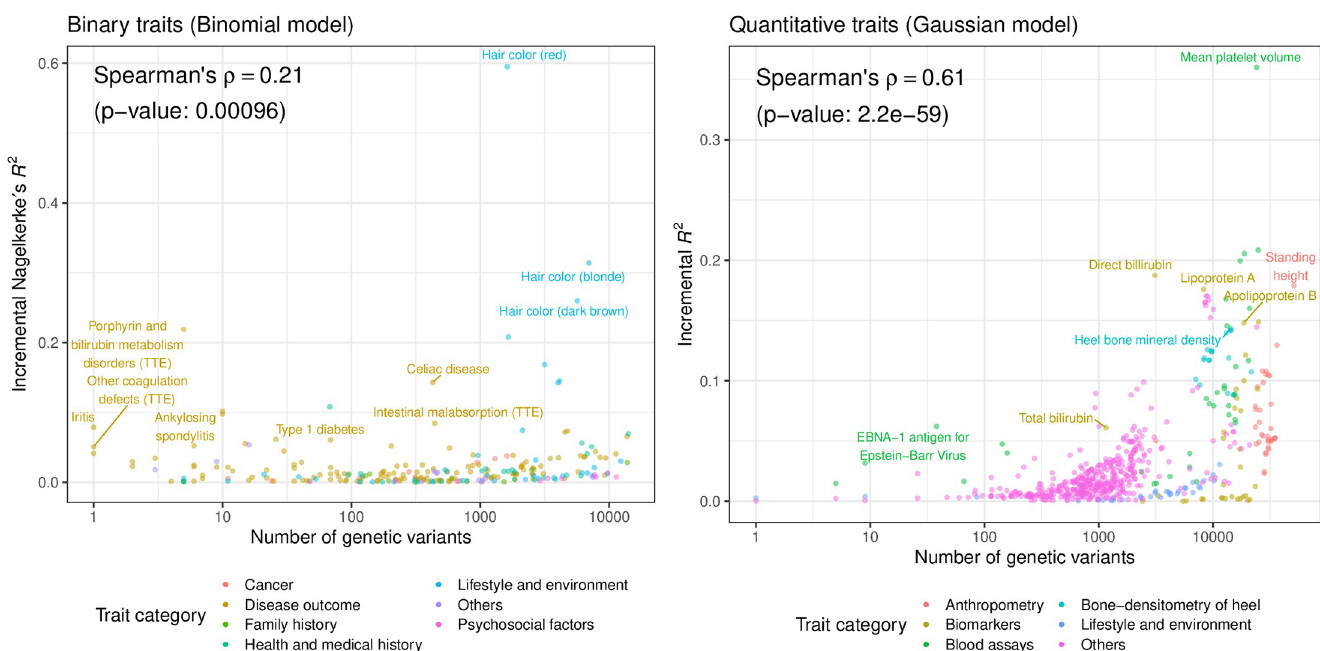
Fig 5. Comparison of the effect size and the model size of sparse PRS. The number of the genetic variants included in the model (size of the model, x-axis) and the incremental predictive performance (effect size of the model, y-axis) are shown for 244 binary traits (left) and 569 quantitative traits (right). TTE: time-to-event